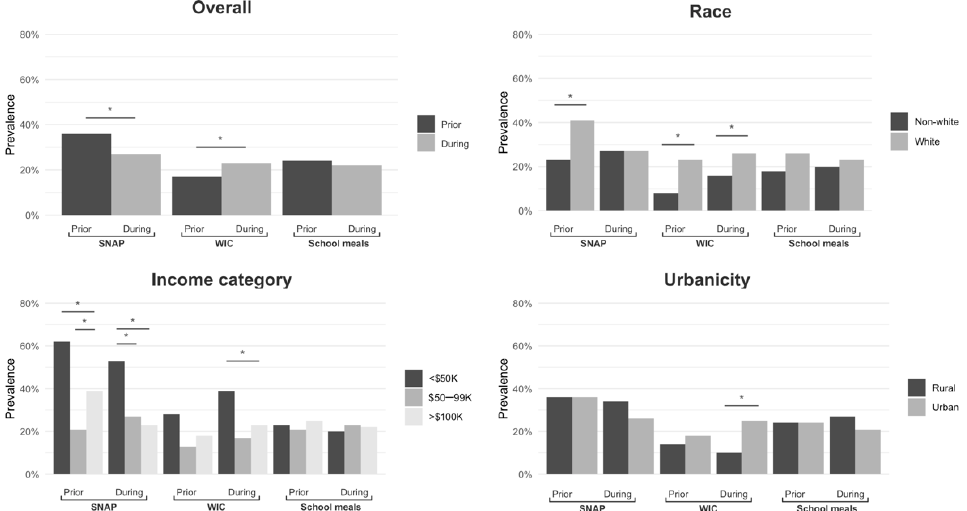
Figure 1. Adjusted prevalence for SNAP, WIC, and school meals participation in the 12 months prior to the pandemic by household demographic characteristics. Asterisks represent statistically significant differences. Abbreviations: Supplemental Nutrition Assistance Program (SNAP); Special Supplemental Nutrition Program for Women, Infants, and Children (WIC).